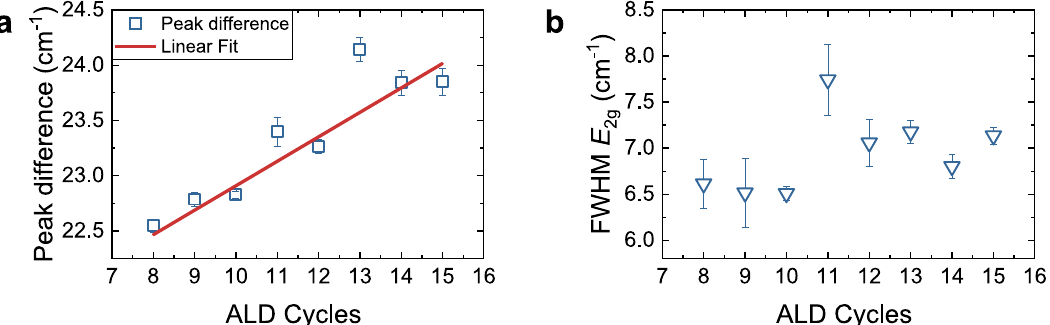
Fig. 5 Raman scattering of MoS2 by varying ALD cycles. a Peak difference between E 2g and A 1g for MoS 2 /SiO 2 /Si with ALD cycles from 15 down to 8. Each data point is an average of 3 different areas per sample, with the error bars originating from the standard deviation of the 3 measurements. A linear fi t with peak difference and cycle number is seen. b Full Width Half Maximum of E 2g peaks for MoS 2 /SiO 2 /Si samples with ALD cycles from 15 down to 8. Each data point is an average of 3 different areas per sample, with the error bars originating from the standard deviation of the 3 measurements. No trend with E 2g FWHM and ALD cycle number is